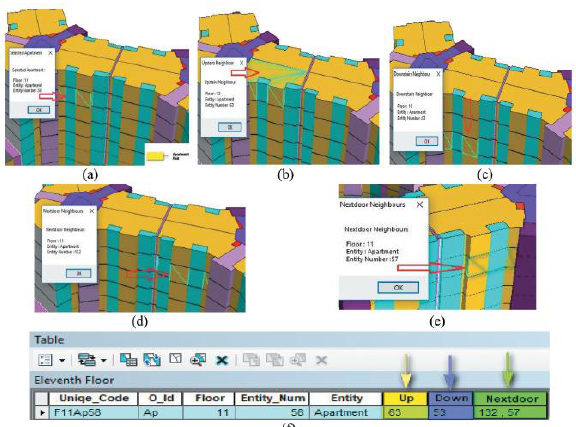
Figure 1 . 3D unit with queried adjacent units based on close proximity analysis (Emamgholian et al., 2021).